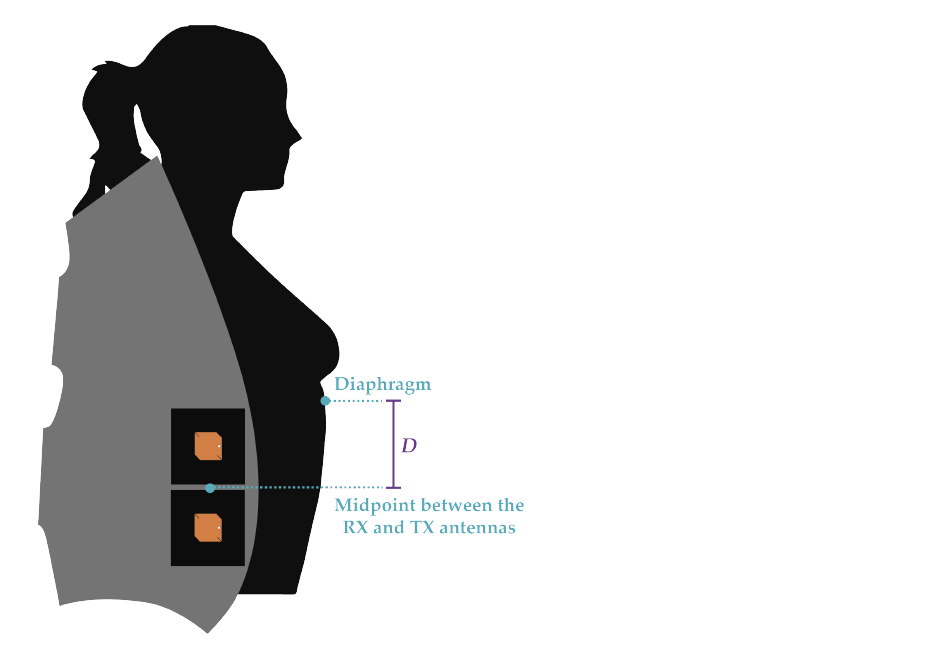
Figure 19. Set-up for the six subject experiment, side view.